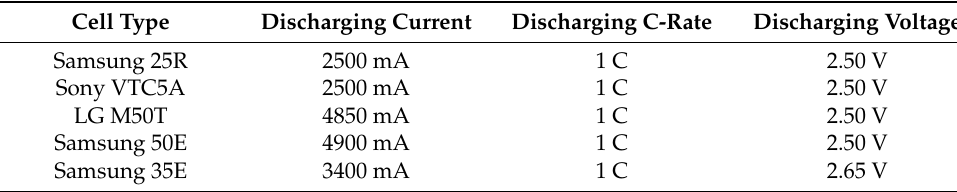
Table 3. Discharging parameters of the cycle